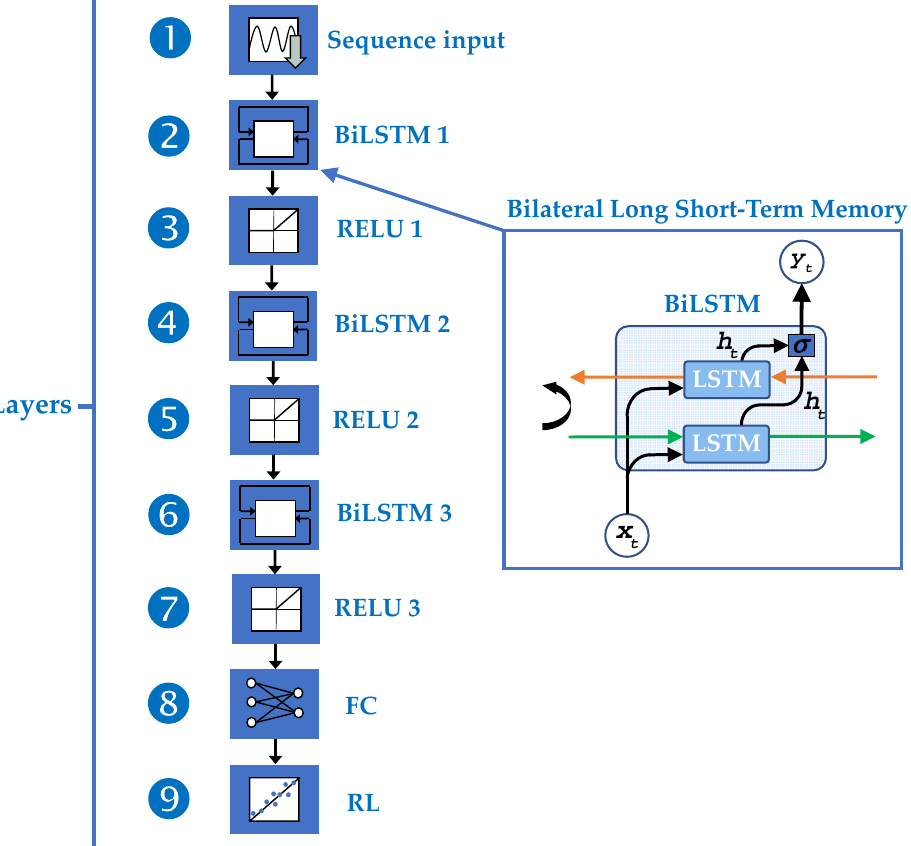
Figure 7. Architecture of long short-term memory (LSTM) network created for anomaly detection. Table 5. Hyperparameters defining the architecture of the LSTM network.